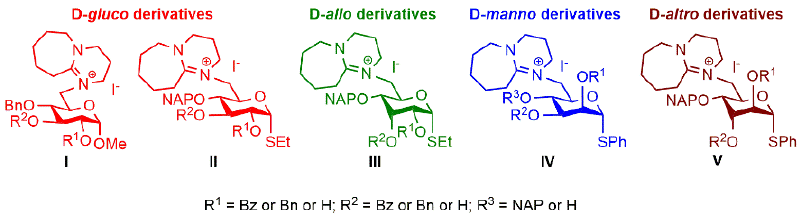
Figure 2. The structure of the synthesized quaternary amidinium salts.